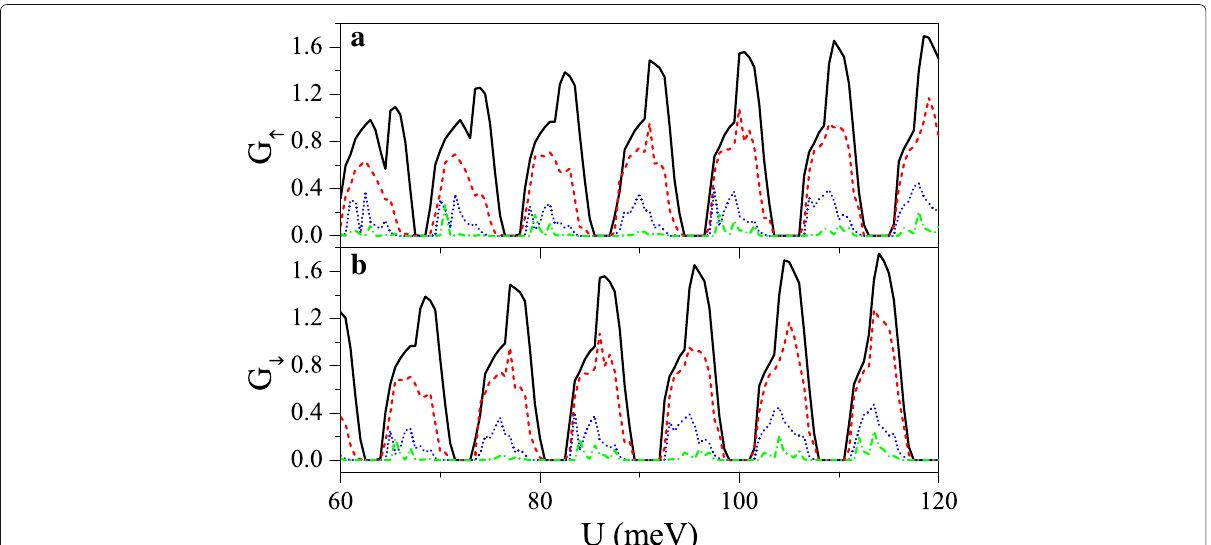
Fig. 10 Conductances ( a ) G ↑ and ( b ) G ↓ versus potential U , when the electric field presents disorder, at n = 50 and (cid:2) z 0 = 20.0 meV. The solid, dashed, dotted, and dash-dotted curves correspond to the disorder strength δ = 0.0, 0.1, 0.3, and 0.6, respectively. The values of other parameters are the same as these in Fig. 8